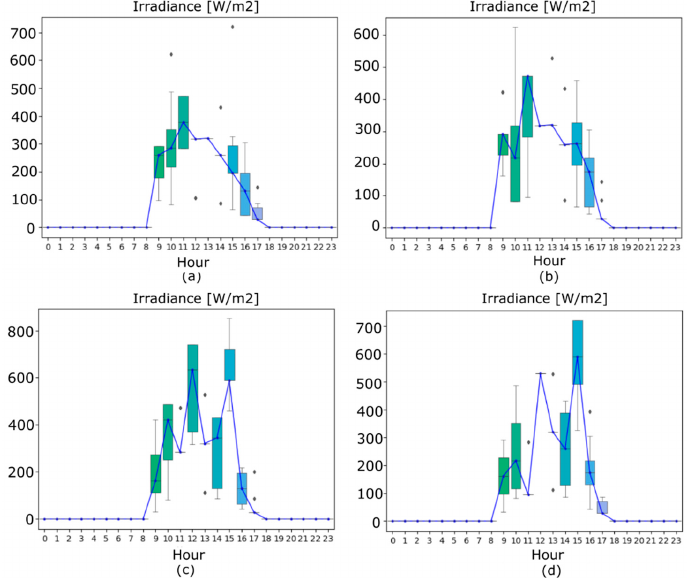
Figure 10. Median scenarios (blue) with box-whisker plot for scenarios generated for January using 𝑛 (cid:3020) = 1000 , 𝑛 (cid:3017) = 10 , and 𝑛 (cid:3019) = 7 without outlier removal and varying the type of metric : ℓ (cid:2869) -Norm ( a ), ℓ (cid:2870) -Norm ( b ), ℓ (cid:2872) -Norm ( c ), and ℓ (cid:2998) -Norm ( d ).